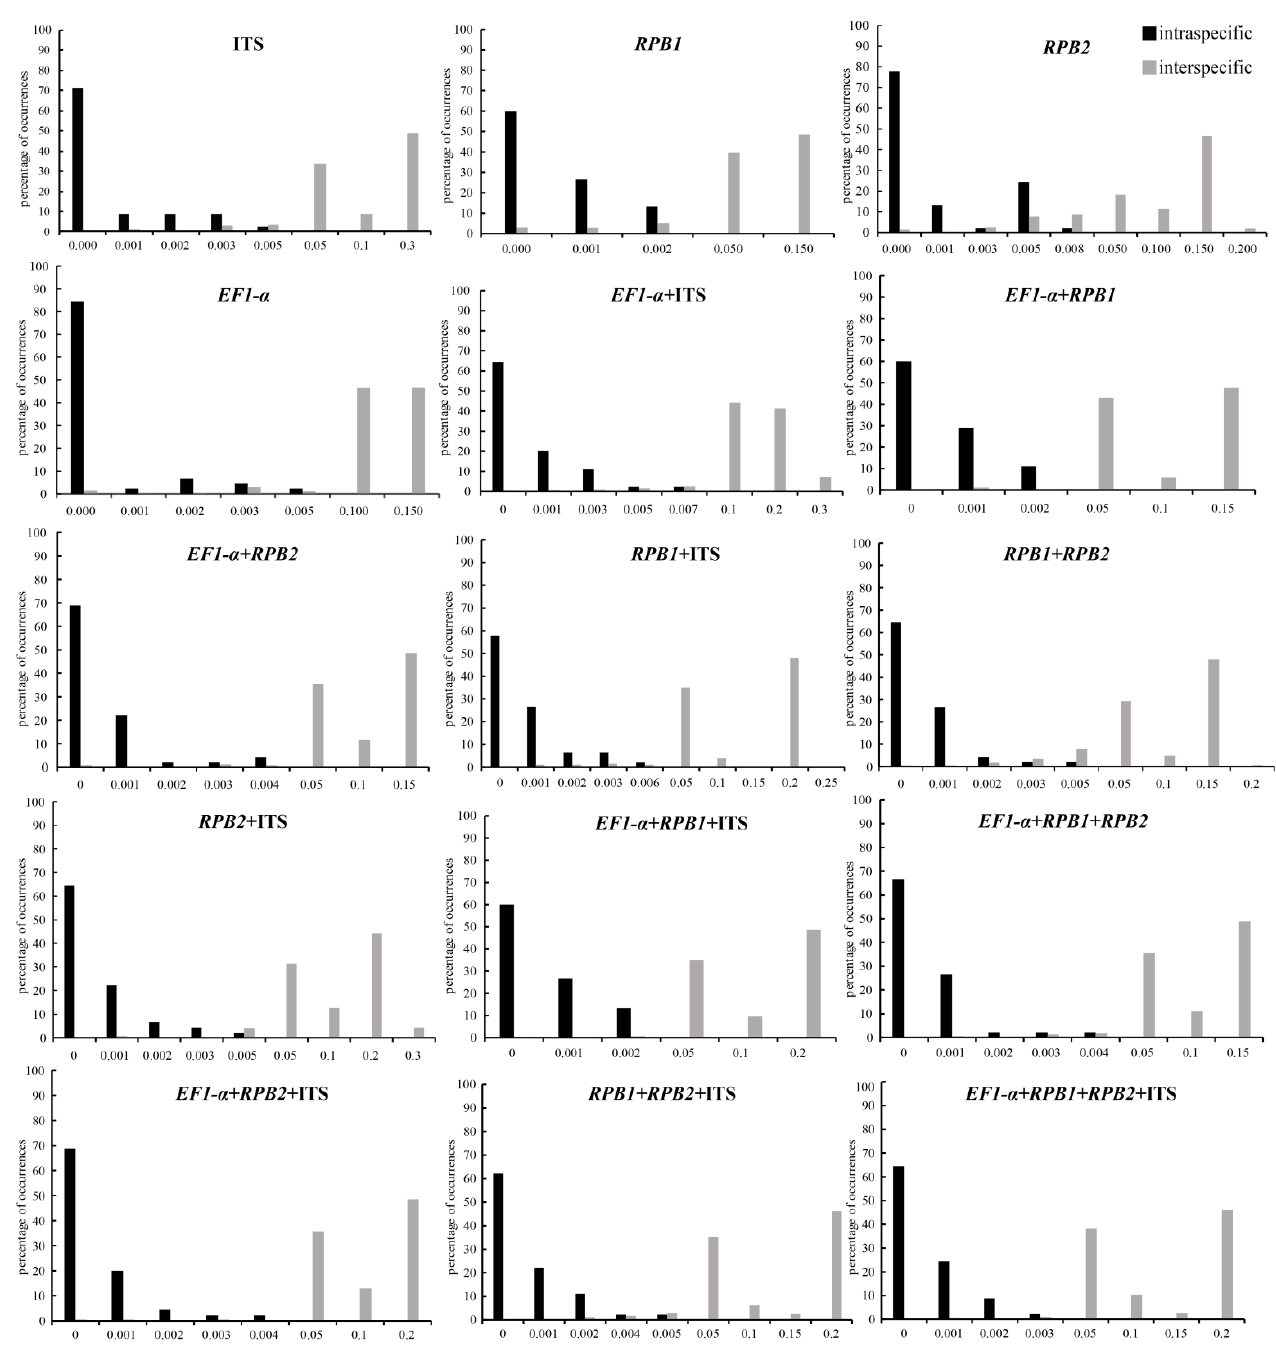
Figure 2. Histograms of the frequencies ( y -axes) of pairwise intraspecific (black bars) and interspecific (gray bars) divergences based on the K2P distance ( x -axes) for four single (ITS, RPB1 , RPB2 and EF1- α ) and eleven candidate combination DNA markers.